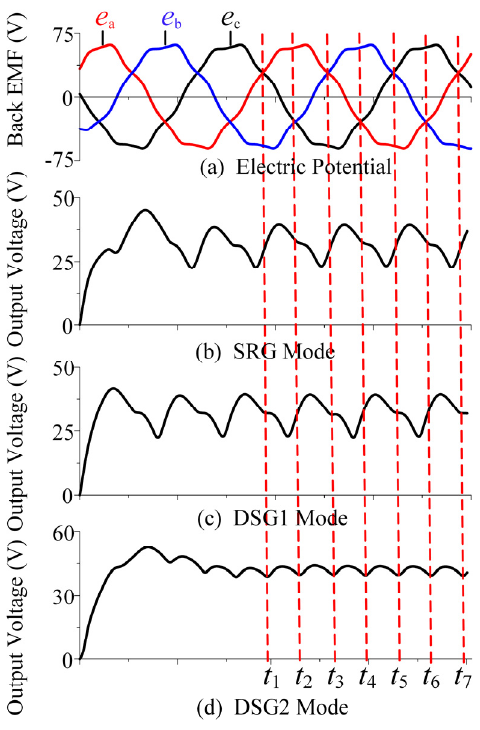
Figure 9. The output voltages of three power generation modes.